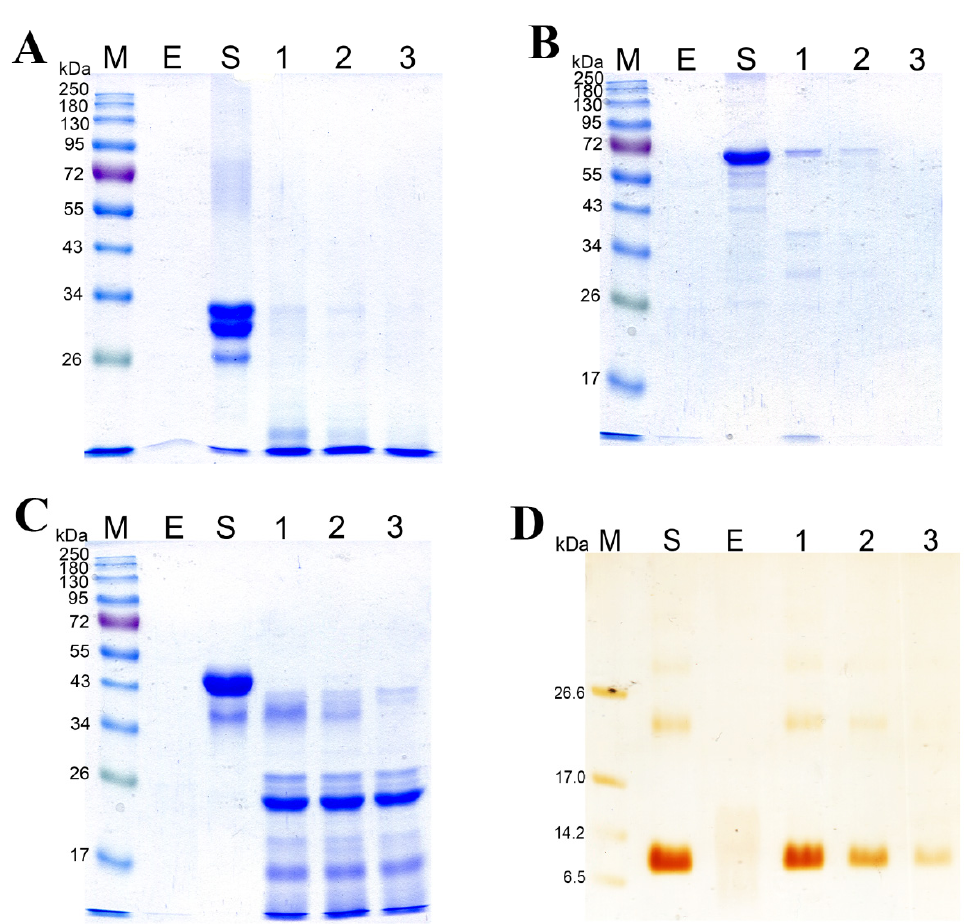
Figure 6. Degradation of the casein sodium salt ( A ), BSA ( B ), ovalbumin ( C ), and β -keratin ( D ) by the enzymatic extract from Bacillus sp. A5.3 depending on incubation time. M, protein molecular weight markers. E, enzymatic extract without a substrate; S, substrate. In ( A ): lane 1, 15 s; lane 2, 30 s; and lane 3, 60s. In ( B ): lane 1, 5 min; lane 2, 15 min; and lane 3, 60 min. In ( C ): lane 1, 1 min; lane 2, 5 min; and lane 3, 15 min. In ( D ): lane 1, 30 min; lane 2, 60 min; and lane 3, 120 min.